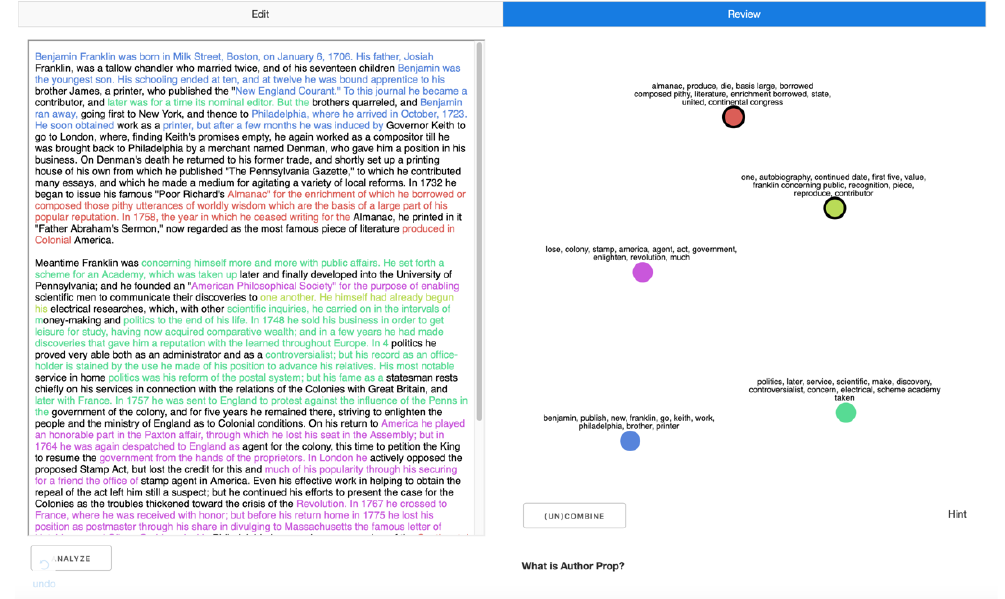
Figure 3 . Author Prop’s Review